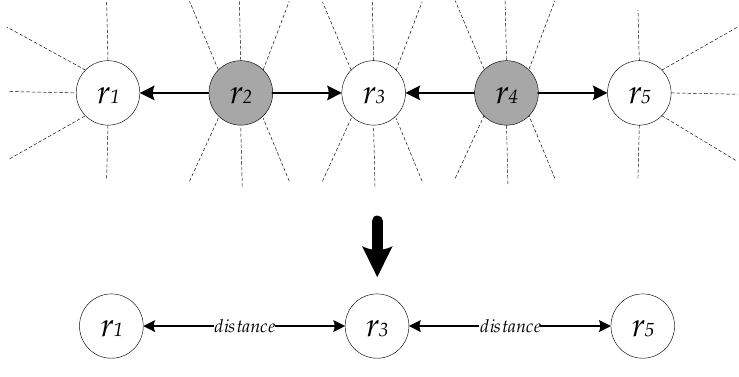
Figure 4. LOD graph reduction example.